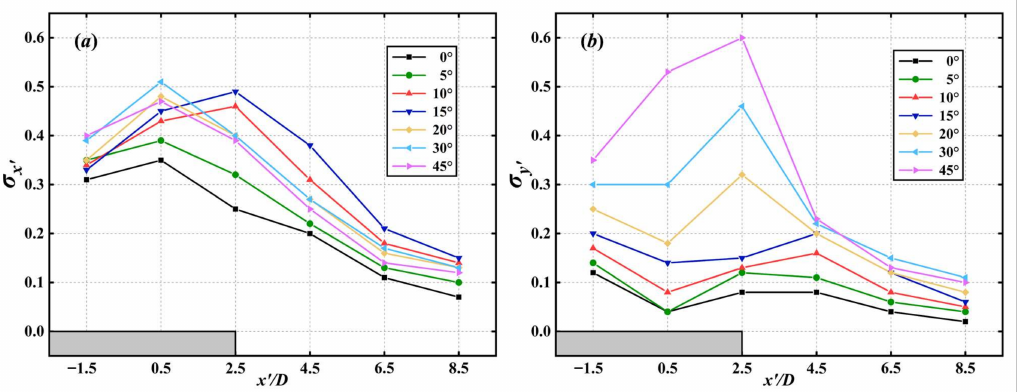
Figure 15. The standard deviation of time-averaged velocity: ( a ) velocity along the direction of the cylinder, ( b ) velocity in the direction perpendicular to the